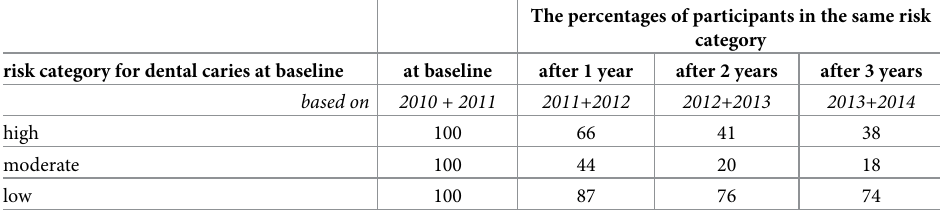
Table 6. Percentages of participants in the same risk category after 1, 2 and 3 years.